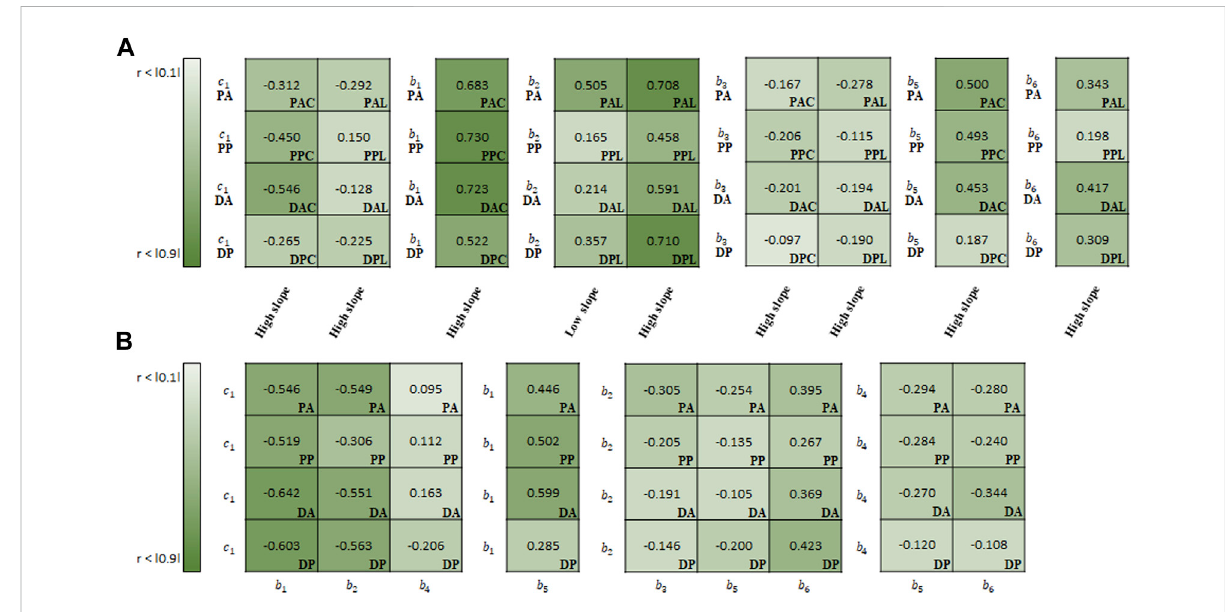
FIGURE 9 Spearman rank correlation coef fi cients (A) between material parameters of Fung model and experimental results and (B) among the material parameters.